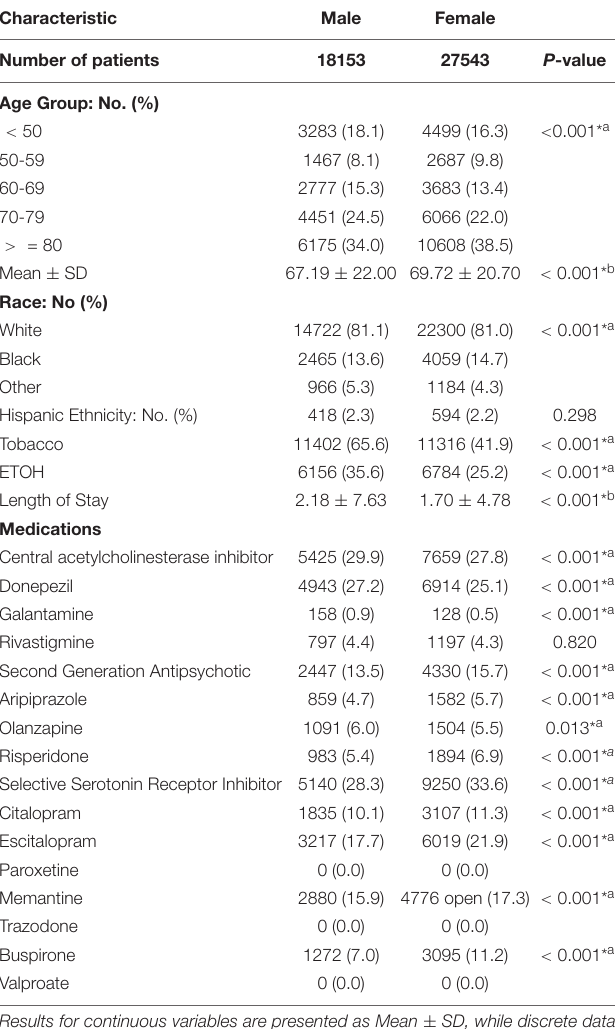
TABLE 1 | Sex differences of demographic and clinical characteristics in mild cognitive impairment and dementia patients.